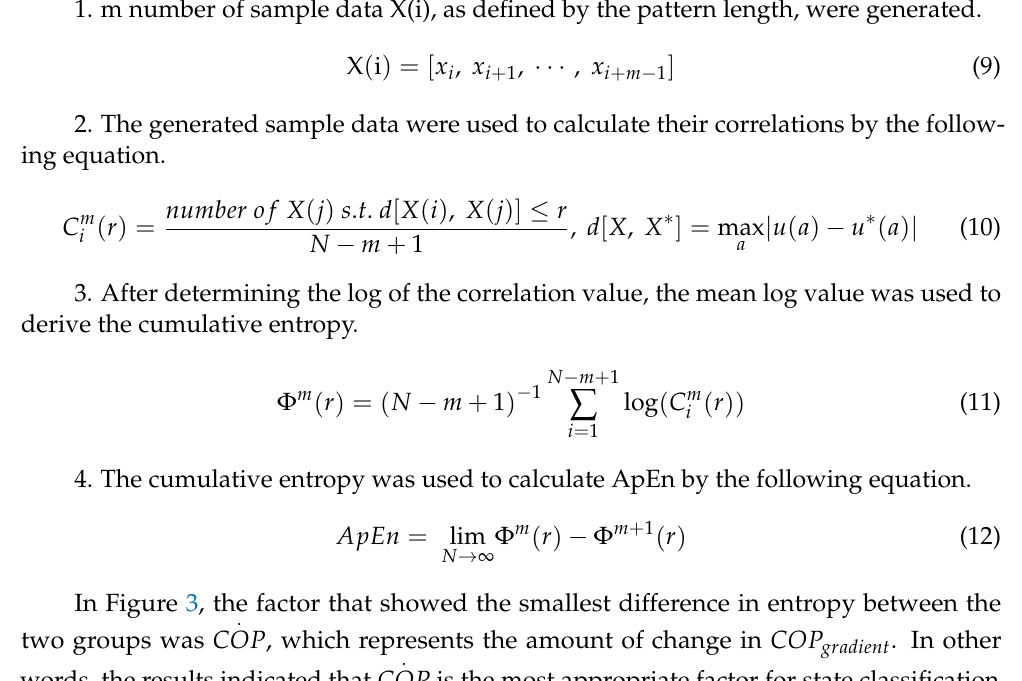
Figure 3. Comparison of approximate entropies of the factors.